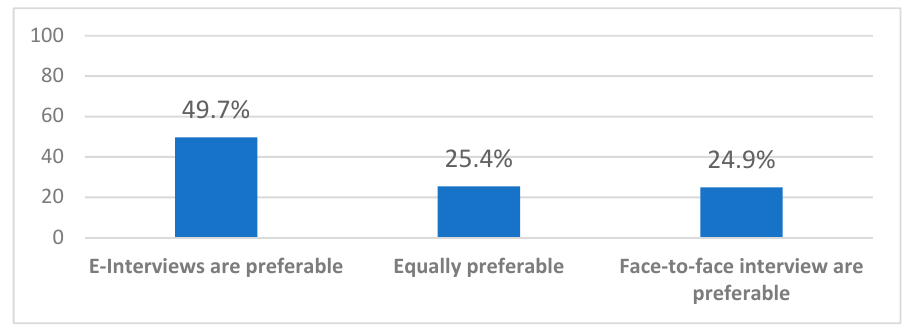
Figure 7. Faculty members future preference of virtual interviews vs. face-to-face.